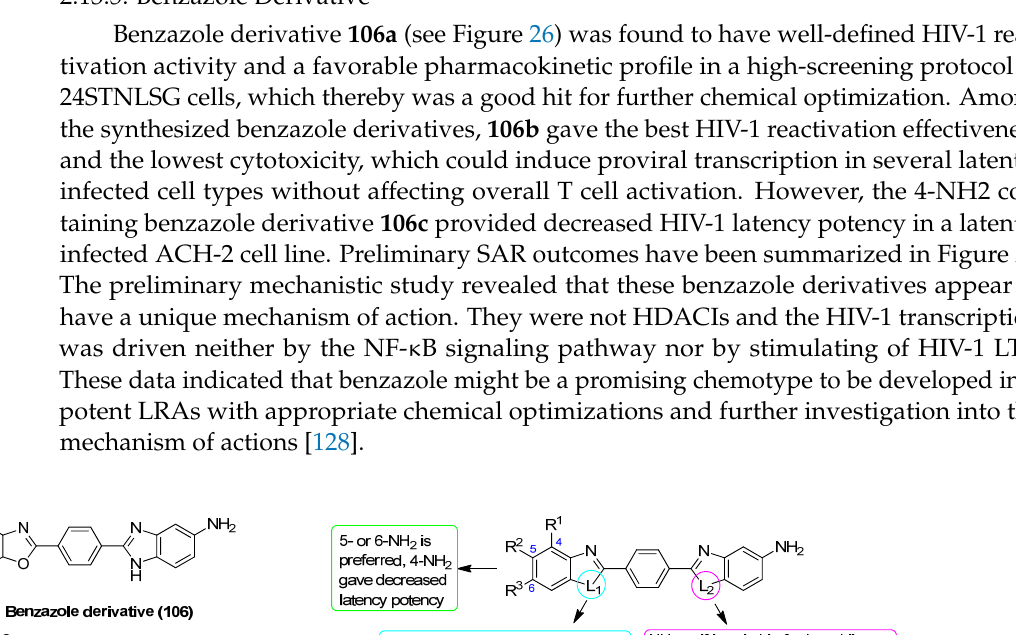
Figure 25. Chemical structure of carbazole derivative CBL0137 (105).